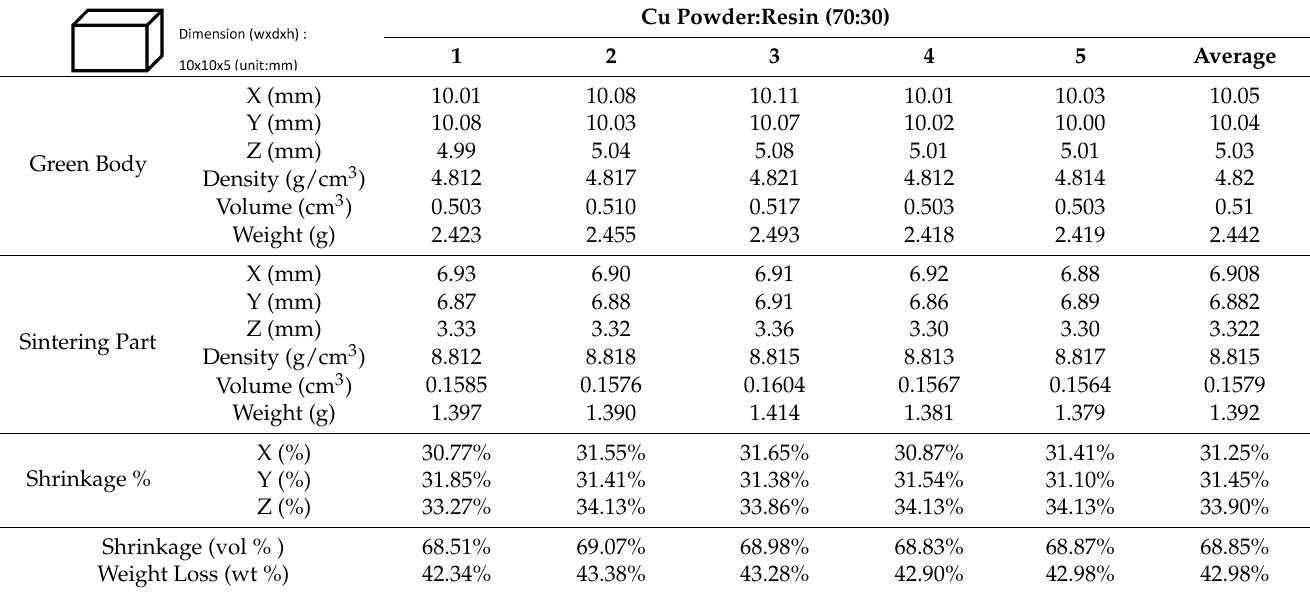
Table 3. Dimensions of the Copper specimen before and after sintering. Cu powder : Resin